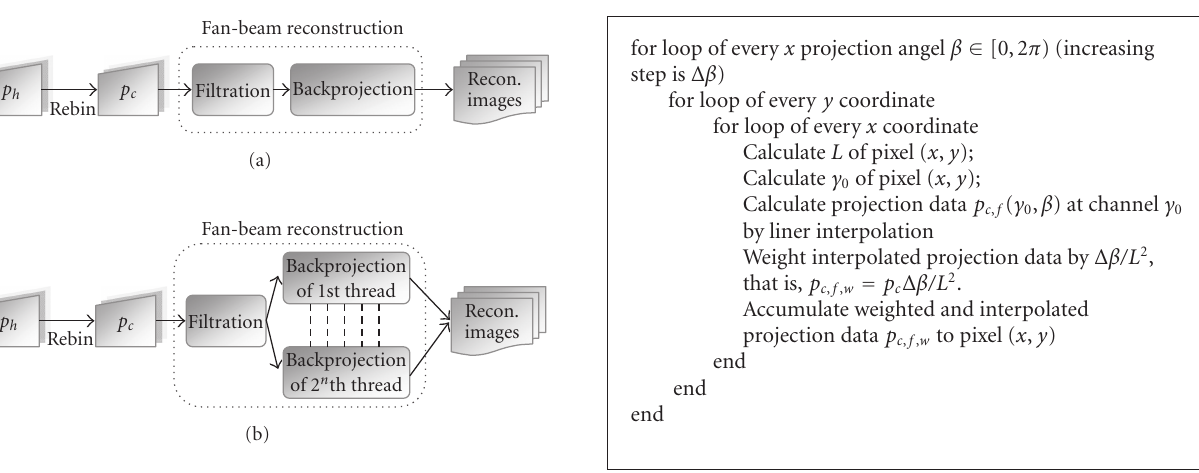
Figure 4: Flowchart of the helical CT reconstruction algorithm: (a) process with one thread, and (b) with multithreads.